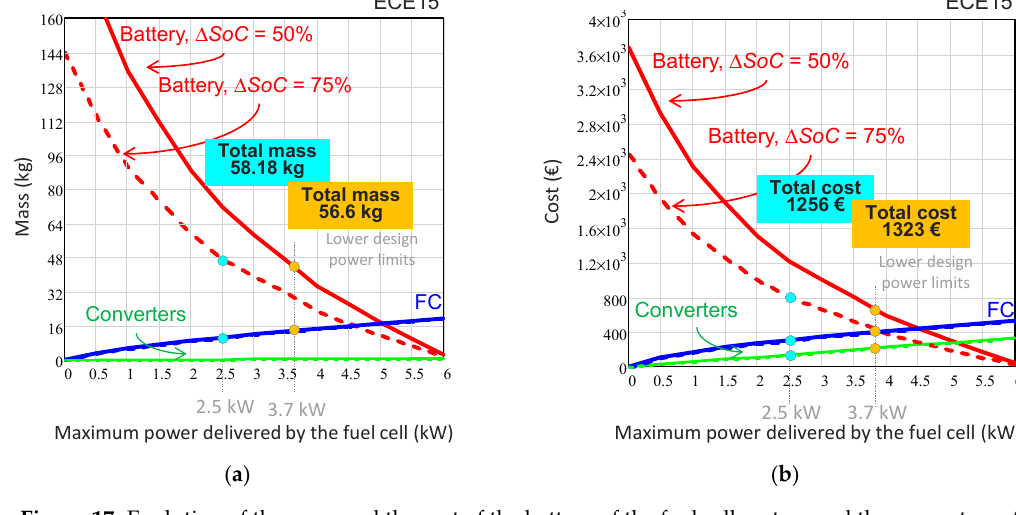
Figure 17. Evolution of the mass and the cost of the battery of the fuel cell system and the converters of electric power distribution system 1B, with variations in the state-of-charge of the battery of 50% and 75% for the ECE-15 driving profile. ( a ) Battery mass. ( b ). Battery cost.